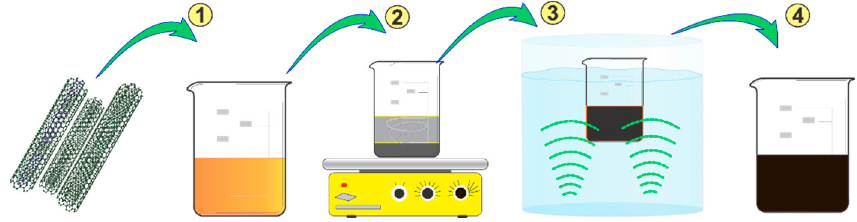
Figure 2. Procedure used to disperse MWCNTs within the vinyl ester resin prior to resin infusion.